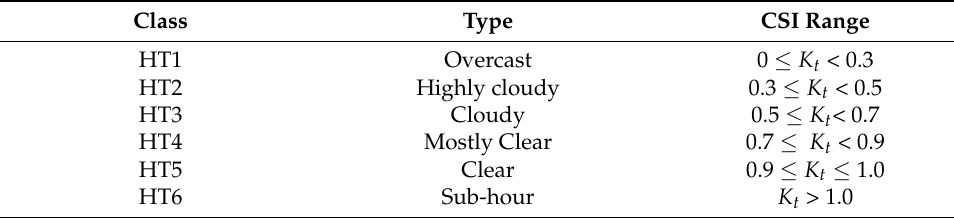
Table 1. Hour type classification based on CSI.